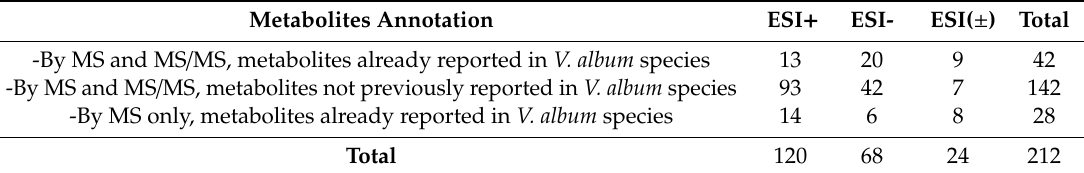
Table 1. Number of metabolites putatively annotated in Viscum album samples by liquid chromatography − high resolution tandem mass spectrometry (LC-HRMS/MS).